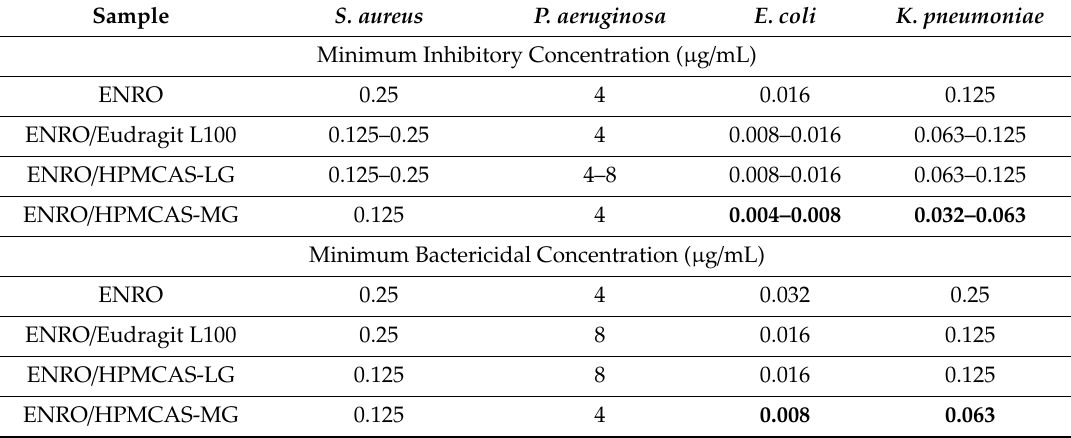
Table 2. Minimum inhibitory concentration and minimum bactericidal concentration of enrofloxacin and ASDs in various bacteria a .